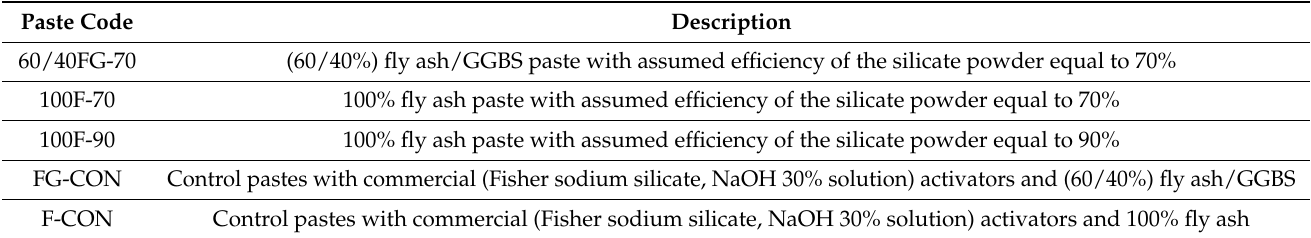
Table 3. Paste code